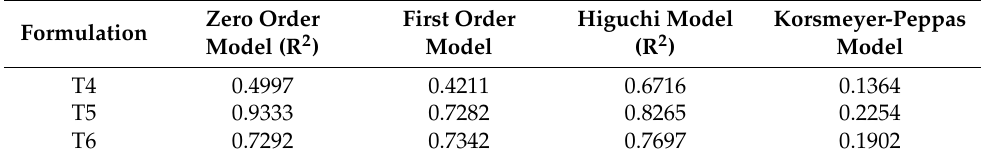
Table 3. In vitro kinetic modeling of CBD release from the transfersomes. Formulation